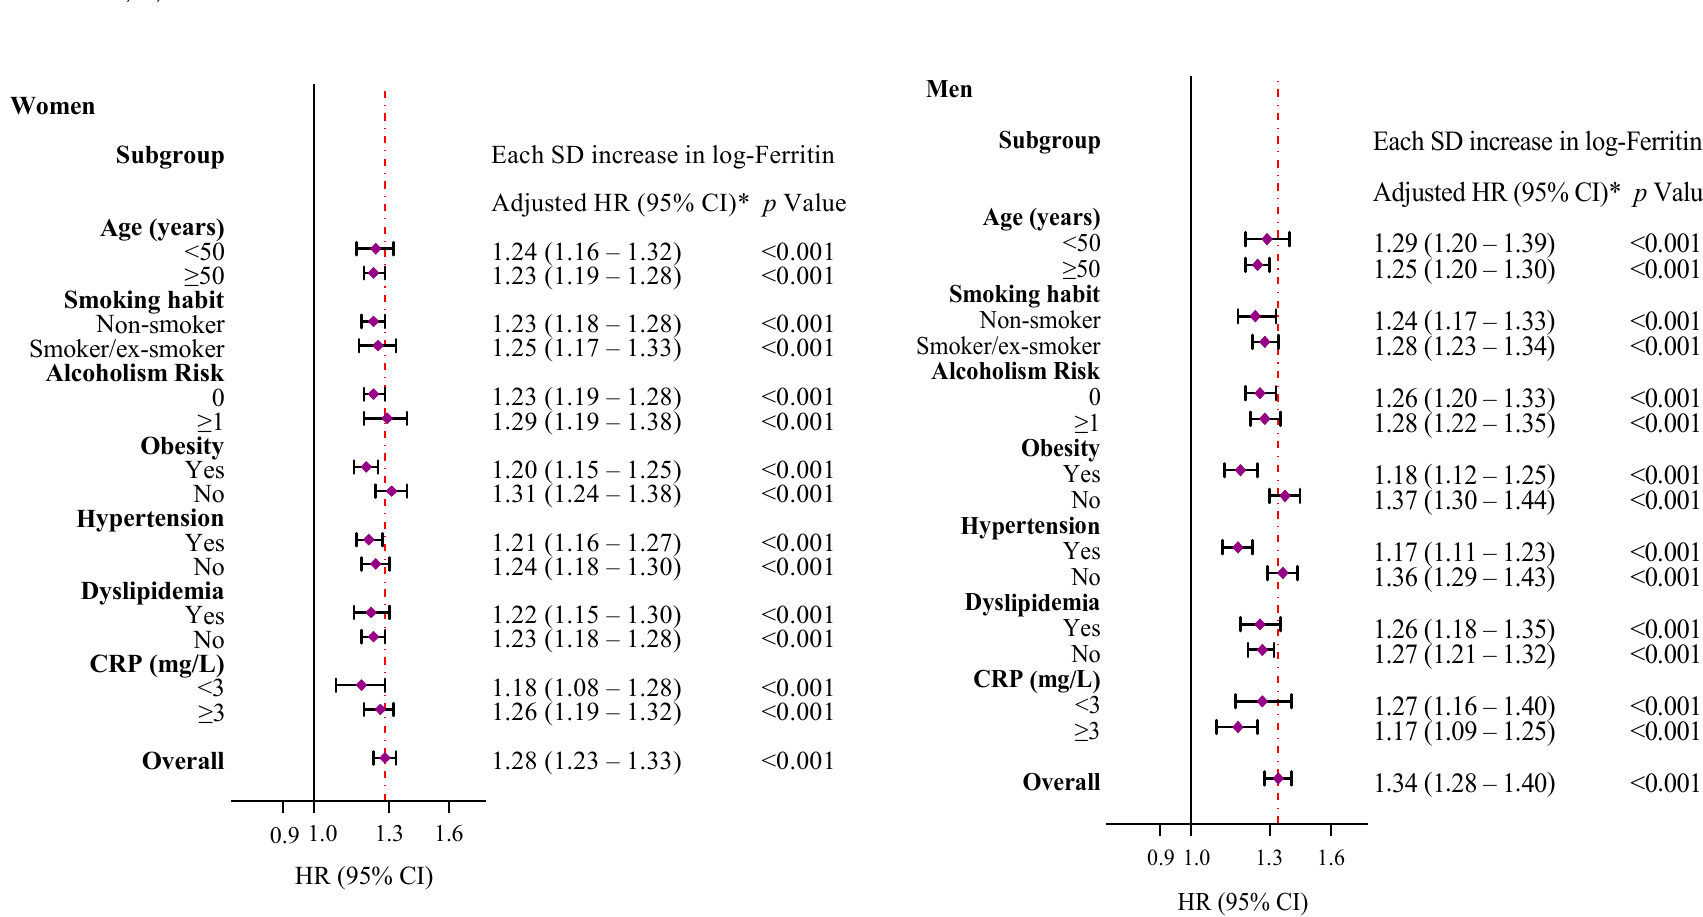
Figure 4. Cox proportional-hazards regression models were used to calculate HRs (95% CIs) for type 2 diabetes associated with 1-SD increase in log-ferritin for selected subgroups, separately for men and women. * Models were adjusted for age (years), smoking (smoker, non-smoker or ex-smoker), risk levels for alcoholism (0 or ≥ 1), dyslipidemia (yes or no), hypertension (yes or no) and obesity (yes or no), except for the variables used as a subgroup variable in each case. C-reactive protein was missing in 124,766 (60.5%) observations, and the variable was discarded from further analysis. The diamonds represent HRs, and the whisker plots represent 95% CIs. The vertical lines (red) represent the overall HRs in men and women. HR, hazard ratio; CI, confidence interval; SD, standard deviation; CRP, C-reactive protein.